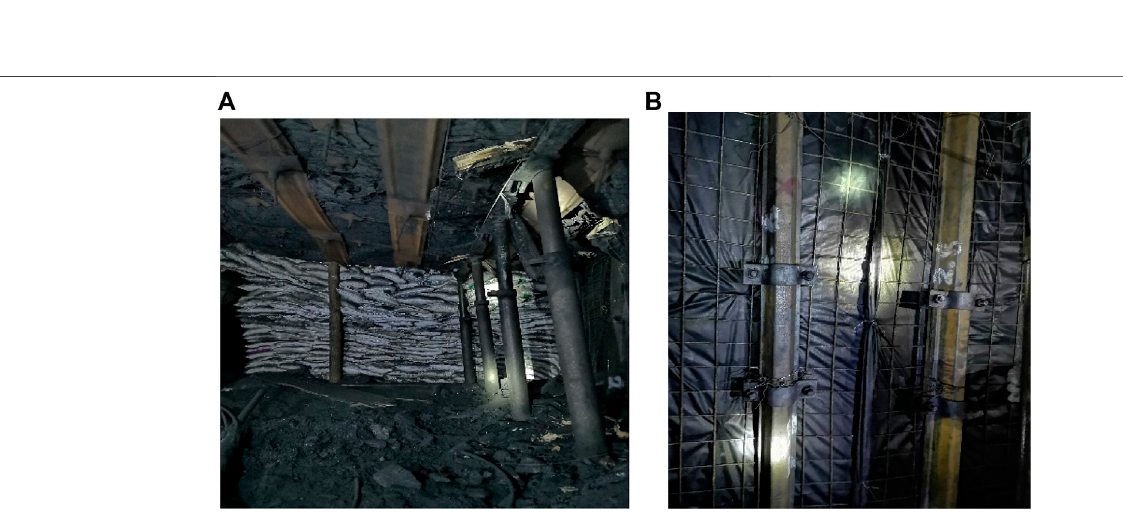
Frontiers in Earth Science |